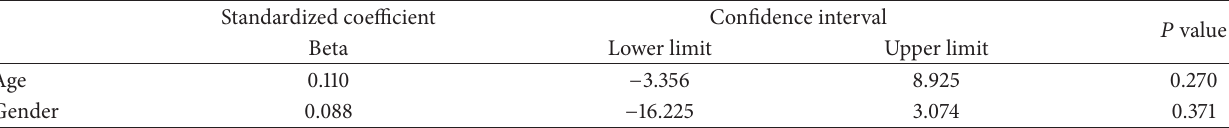
Table 3: Linear regression analysis by age and